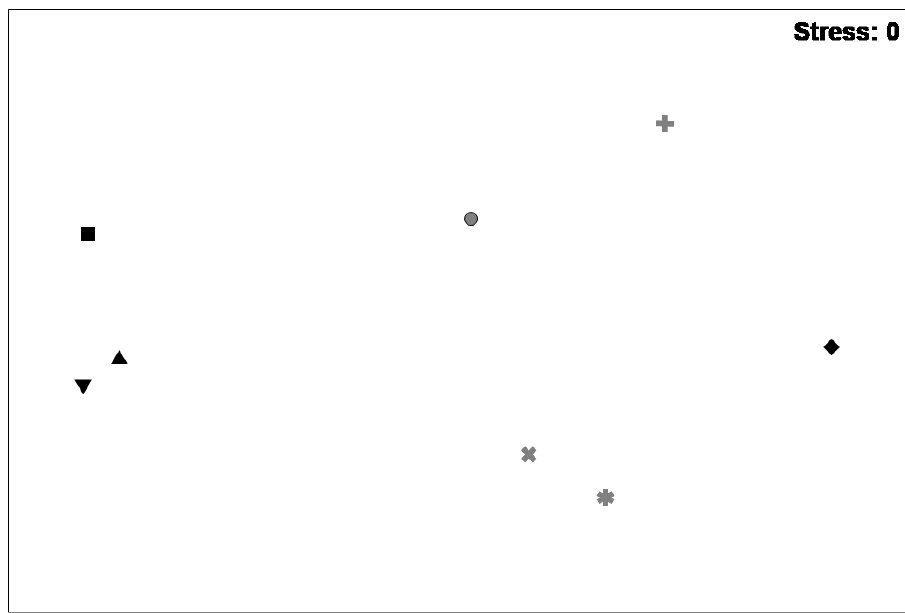
Figure 3. Plots of sampled shores from urbanized (black) and non-urbanized (gray symbols) regions. Different symbols represent different shores.